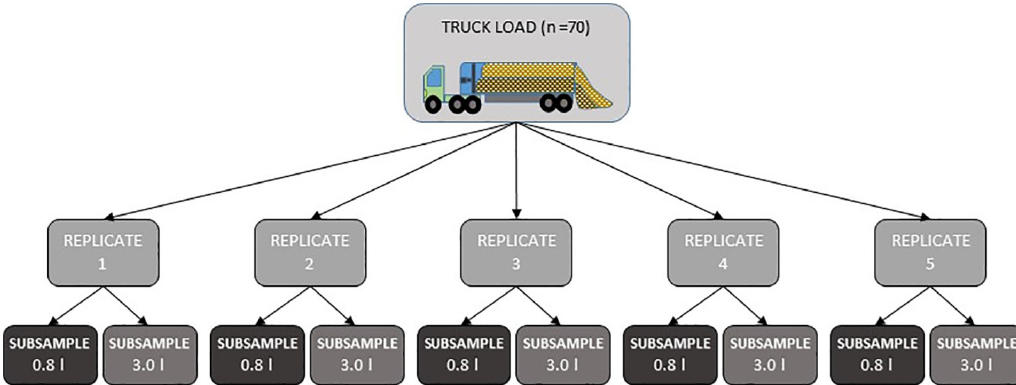
Figure 2. Sampling strategy for the selection of 5 first subsamples (STAN) and 5 s subsamples (FAST) from each incom- ing